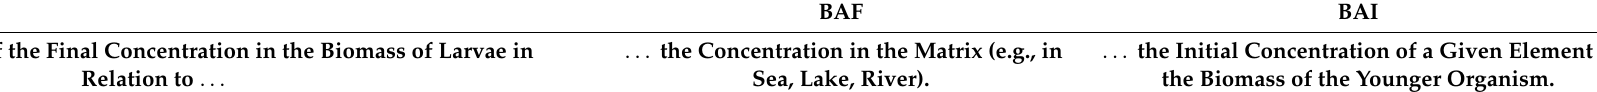
Table 2. The difference in the concept and the interpretation of different threshold values of both bioaccumulation measures.